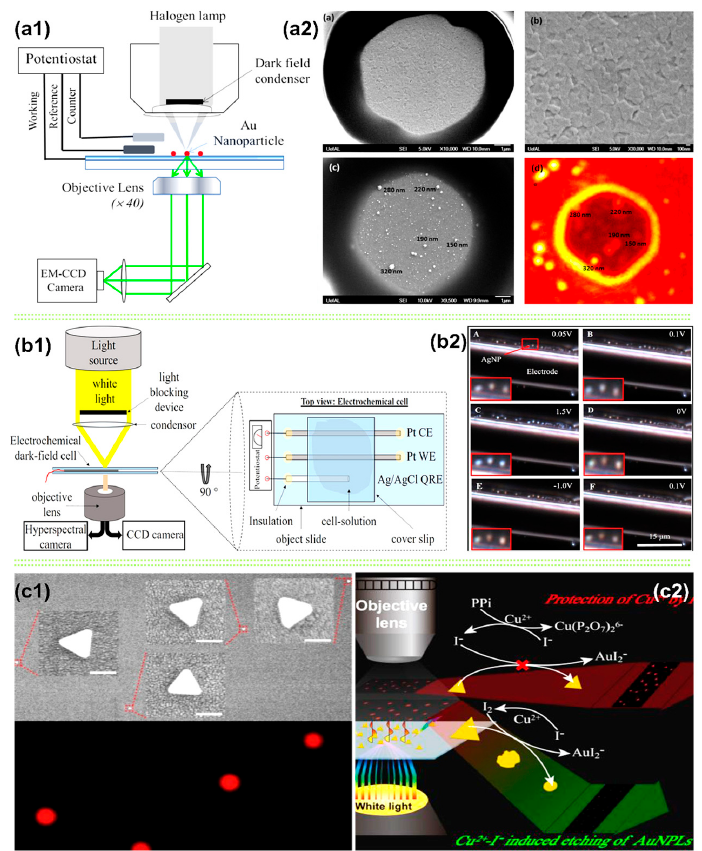
Figure 8. ( a1 ) Experimental schematic of the DFS-EC setup for hydrazine oxidation. ( a2 ) SEM images of a bare ITO ultramicroelectrode (top two images). Reprinted from [80], with permission from ACS Publications. SEM and DFS images of AuNPs’ modified ITO electrode (bottom two images). ( b1 ) Experimental setup of the dark-field microscope and the used electrochemical cell; ( b2 ) DFM CCD images recorded during CV at selected potentials; exposure time: 70 ms. Reprinted from [14], with permission from ACS Publications. ( c1 ) The co-localization images of the DFM and SEM of Au triangular nanoplates (AuNPLs). ( c2 ) Working principle of single-nanoparticle analysis (SNA) for PPi assay. Reprinted from [161], with permission from ACS